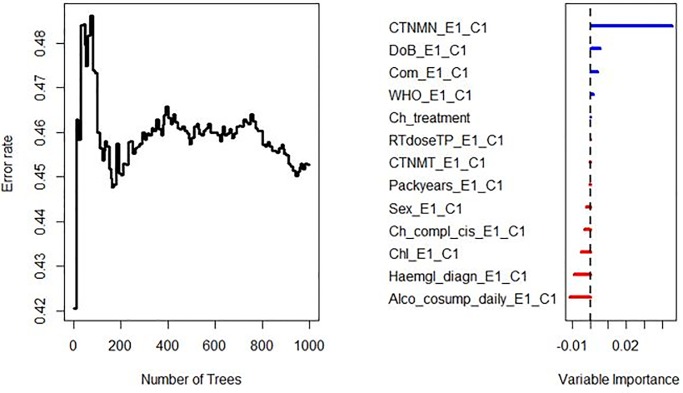
Error rate stabilizes with increasing number of trees.Features with an importance > 0 on an RFSRC model trained with all clinical variables in were eventually combined in the multivariable clinical (prognostic/ treatment-related) RFSRC model and externally validated on the BD2DECIDE dataset.